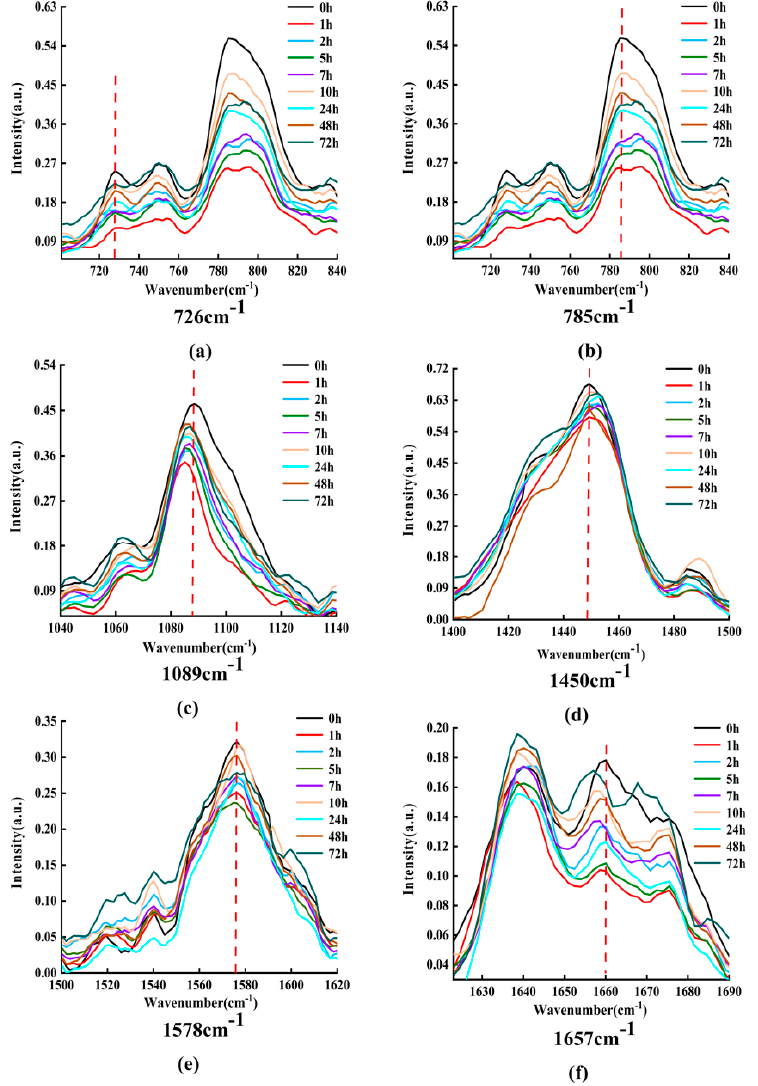
Figure 8. Raman spectra of DOX interacting with DNA at different times. ( a – f ) Raman spectrum of the band at 726, 785, 1089, 1450, 1578, and 1657 cm (cid:2879)(cid:2869) , respectively. In order to clearly express the changing trend of Raman intensity with incubation time, Figure 9 shows the line charts of Raman intensities with incubation time at 726, 785, 1089, 1450, 1578, and 1657 cm (cid:2879)(cid:2869) , in which the horizontal axis is the logarithmic time and the vertical axis represents the Raman intensity.